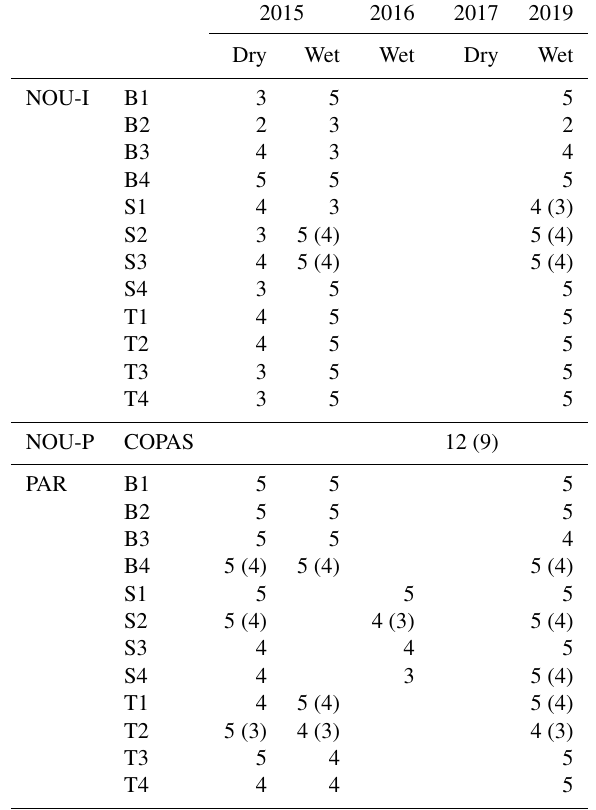
Table 2. Overview of the amount of mature trees and species mea- sured in each plot at Nouragues–Inselberg (NOU-I), Nouragues– Pararé (NOU-P) and Paracou (PAR). Values between brackets indi- cate the amount of different species measured per plot in case this differed from the amount of trees measured per plot. Names of plots are marked by a letter describing the topography (B = bottom, S = slope, T = top) and a number describing the nutrient addition treat- ment (1 = + N, 2 = + NP, 3 = + P, 4 = control), in agreement with Fig. 1c and d.